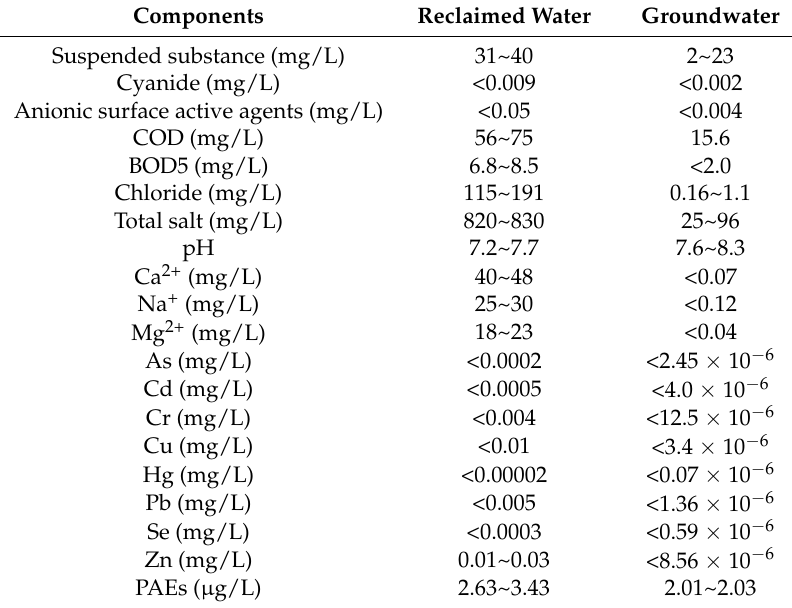
Table 2. The quality of reclaimed water and